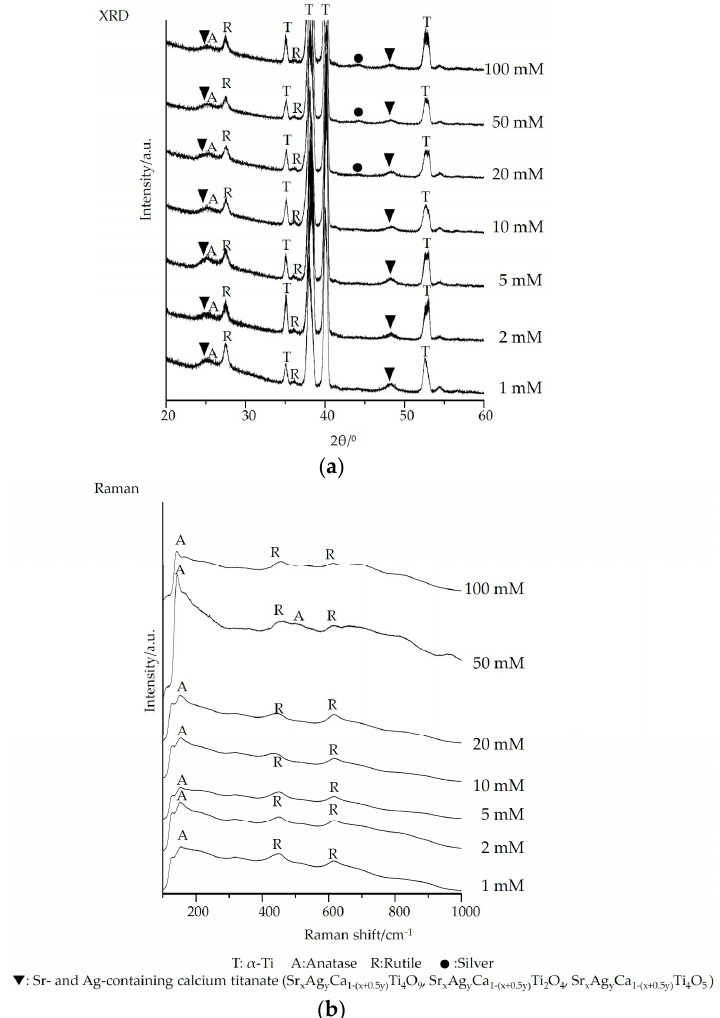
Figure 6. XRD ( a ) and Raman ( b ) spectra of Ti surfaces subjected to Sr + X mM Ag (pH = 4) treatment with various Ag concentrations ( X = 1–100) following NaOH, Ca + Sr and heat